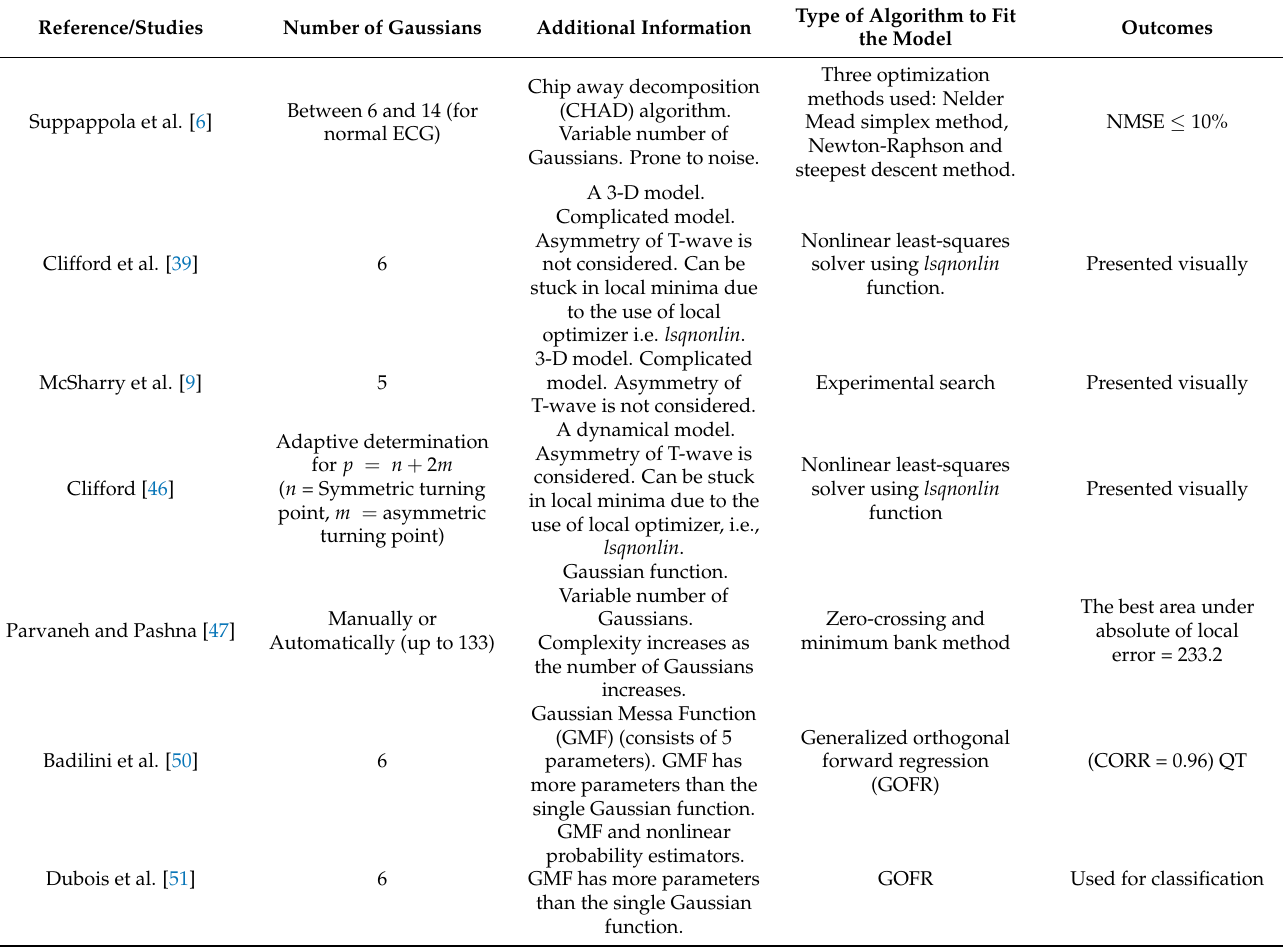
Table 5. Comparison of different ECG methods using a Gaussian